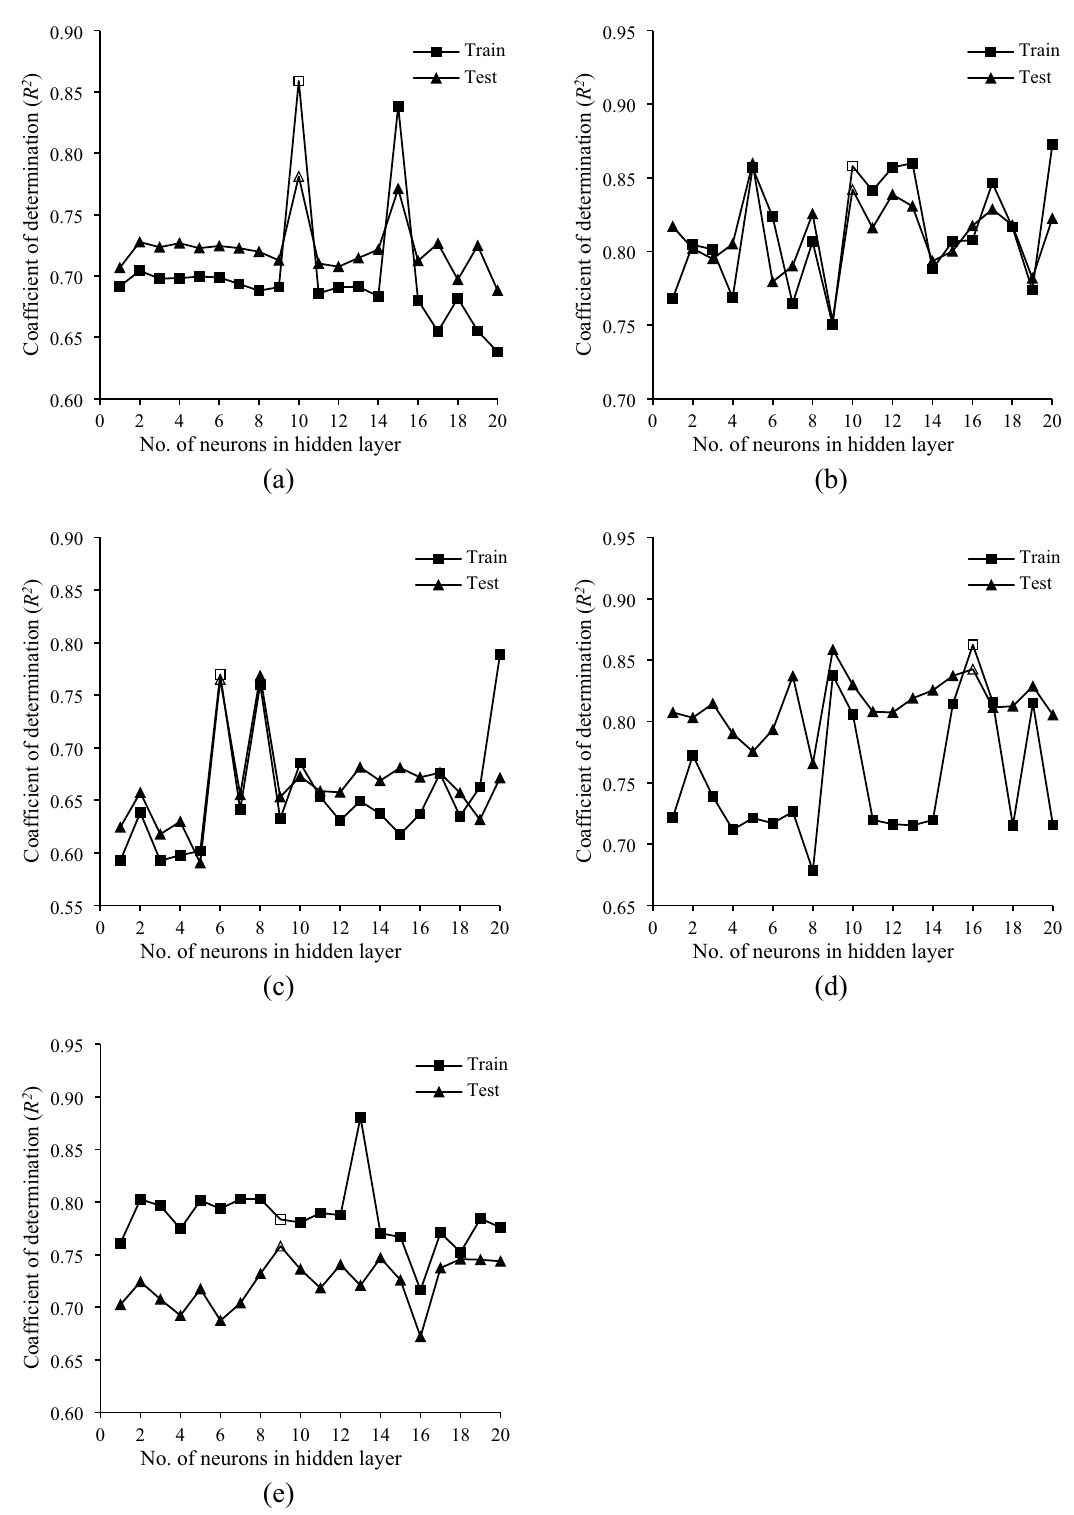
Figure 4. The performance of ANN models versus the number of neurons in hidden layer for estimating ( a ) clay, ( b ) sand, ( c ) silt, ( d ) calcium carbonate equivalent (CCE), and ( e ) electrical conductivity